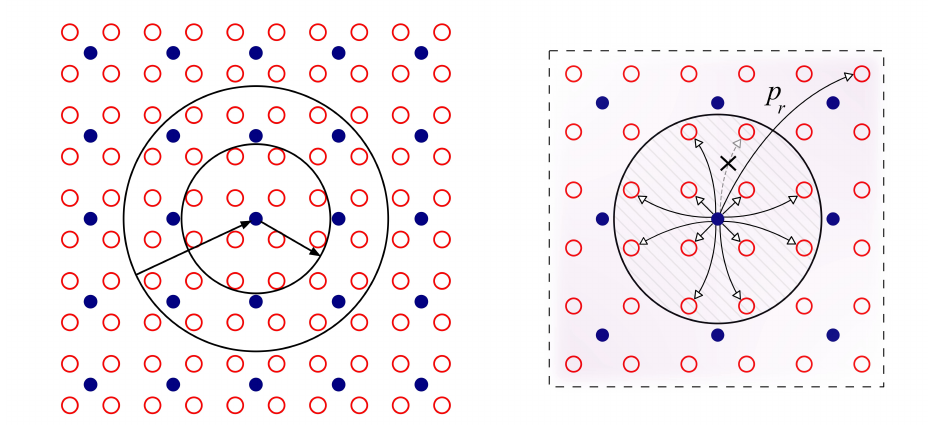
Figure 1. Schemes representing the network topologies used in the present study. ( Left ) The standard network topology used for the generation of brain waves in a E/I balanced cortical neuron population module as in Refs. [12,16]. The neuron coupling scheme represented in the panel is such that the small circle contains 12 E neurons (open red circles) that receive synaptic inputs from the inhibitory neuron (filled blue circle) in its center. On the other hand, the large circle contains 32 E neurons that excite the inhibitory neuron in its center. ( Right ) To see the robustness of the reported results in our study we also use a more complex small-world topology rewiring the given E-I and I-E connections in the network with some rewiring probability p r (see Supplementary Materials for the associated study). In the illustrated example in the figure, one of the inhibitory connections of an I neuron to a given E neuron within its influence circle (as explained in the left panel) is exchanged with probability p r by a new inhibitory connection into other excitatory neuron in a random position in the network.